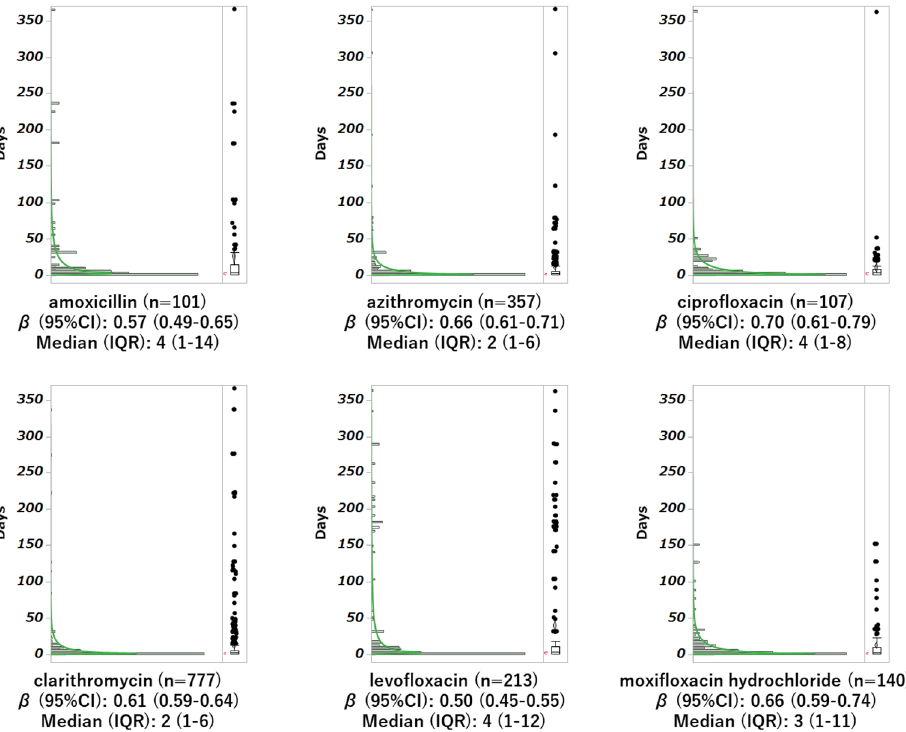
Figure 4. Histogram of antibiotic-induced taste and smell disorders and weibull shape parameters. Adverse event onset time analysis was performed up to 366 days. The median (box center line) and the 25% and 75% quartiles (box ends) are shown to the right of each histogram. The whiskers represent the extreme points ± 1.5 from both ends of the box and represent the largest and smallest values (excluding outliers) of the data within the range. The reliability diamond contains the mean and 95% confidence interval. Parentheses outside the box indicate the shortest range in which 50% of the data are